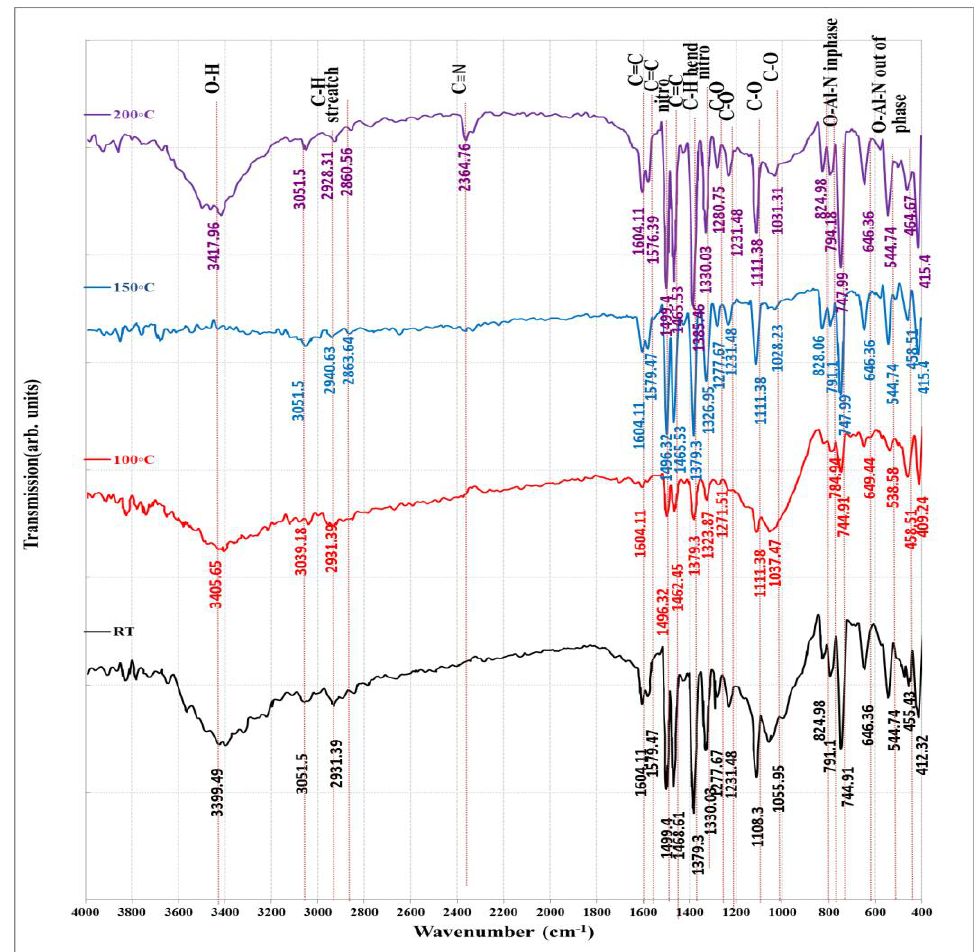
Fig. 6: FTIR for Alq